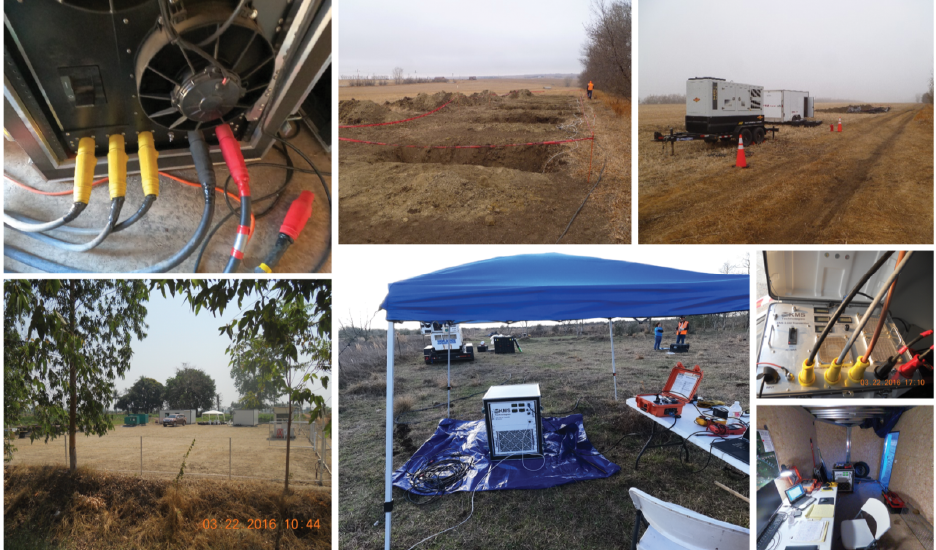
Figure 9. Field images of various components of the transmitter equipment. At the top left is the power connection of the 150 kVA transmitter switch box (back view). Its front view in the field is shown in bottom center. At the top center are pictures of the electrode puts where the current injecting electrode are buried. At the top right is a view of the 150 kVA generator and observer trailer (switch box is inside) used for 24 h continuous for 5 weeks operation partially at minus 20 °C. An inside view of the trailer is at the bottom right. On the left side is a transmitter site set up as camp in the tropic in an oil field.